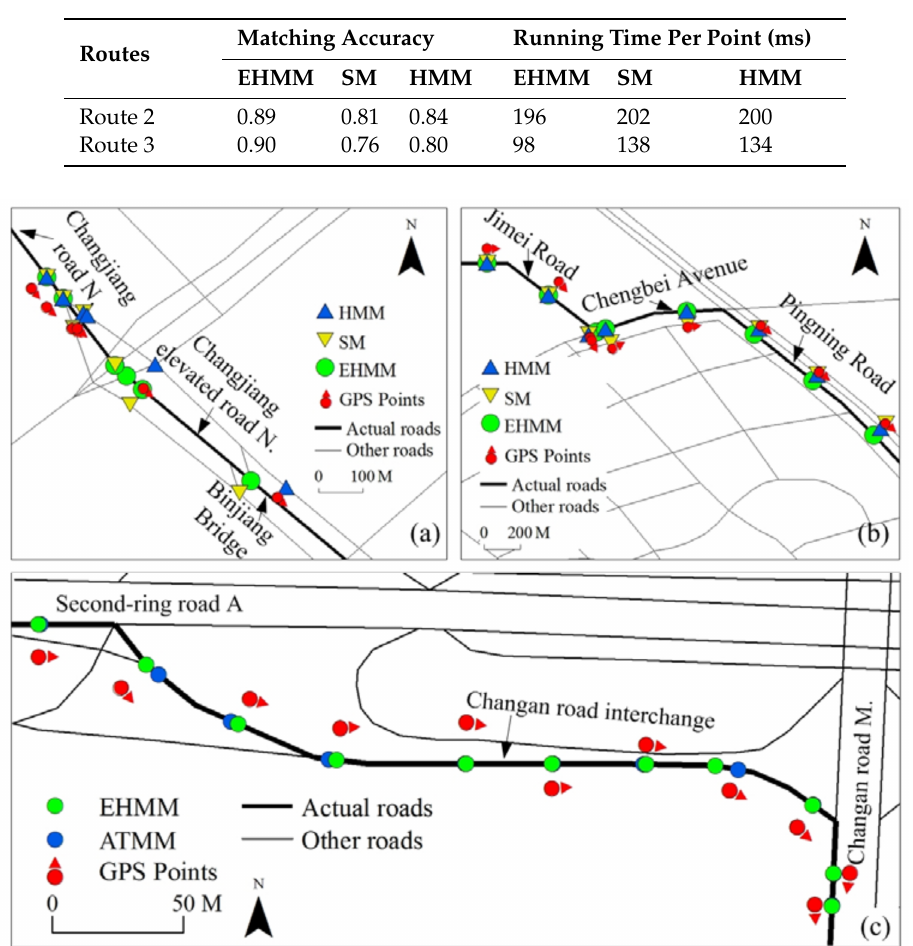
Figure 11. Comparison of matching performances among MM models for part of route 2 ( a ), part of route 3 ( b ) and route 4 ( c